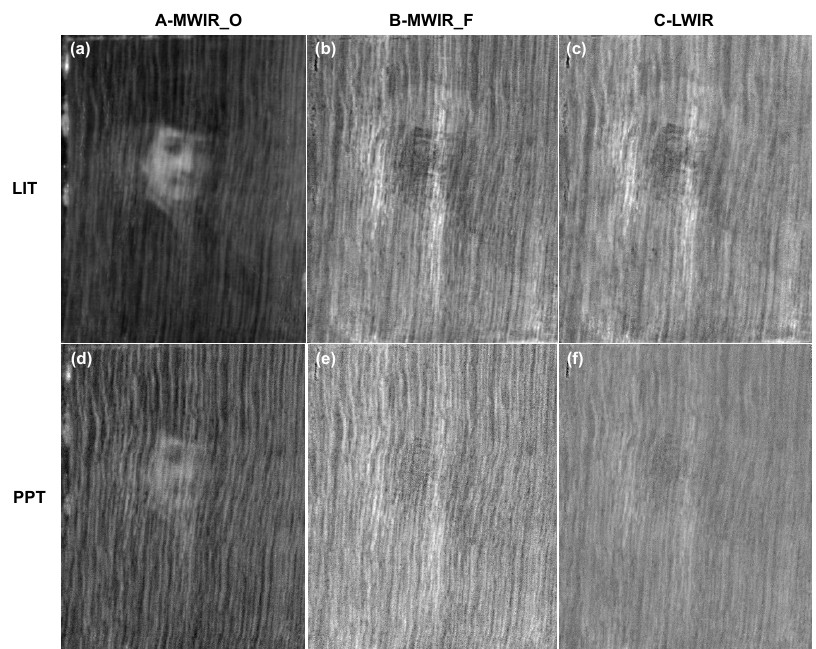
Figure 5. LIT and PPT phase images of the Rembrandt copy for all camera setups. The upper paint layers are almost entirely invisible and the structure of the wooden board is revealed. PPT phase images ( d – f ) show less of the paint layer when compared to LIT phase images ( a – c ). The wood grain contrast seems higher for the images obtained with the B-MWIR setup _F setup ( b , e ) when compared to the C-LWIR setup ( c , f ).